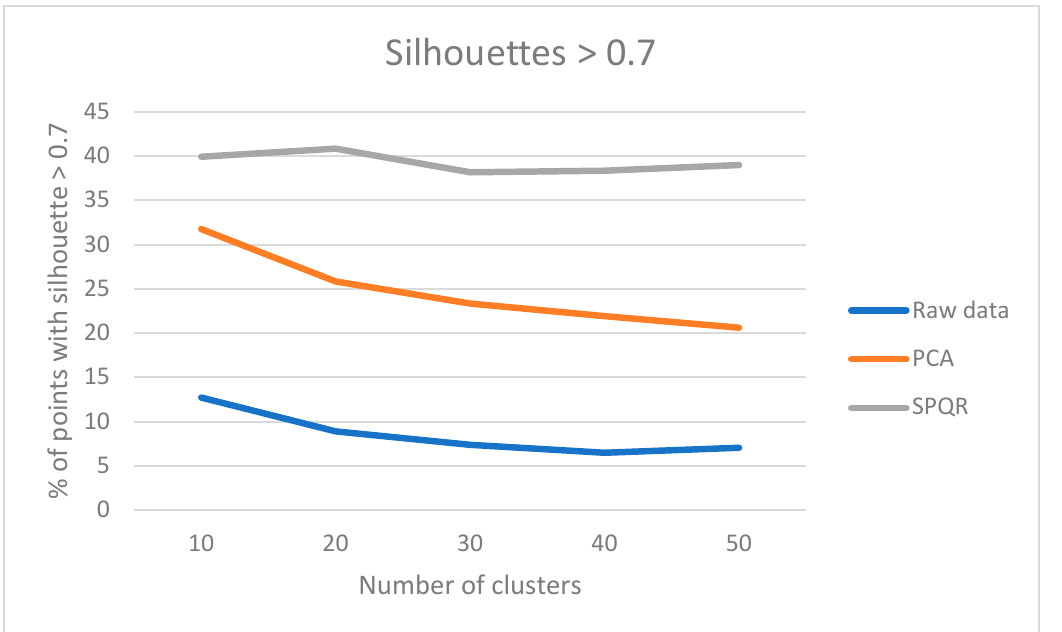
Figure 4. Mean results in terms of silhouettes >0.7 obtained by varying the number of clusters from 10 to 50 using normalized data.